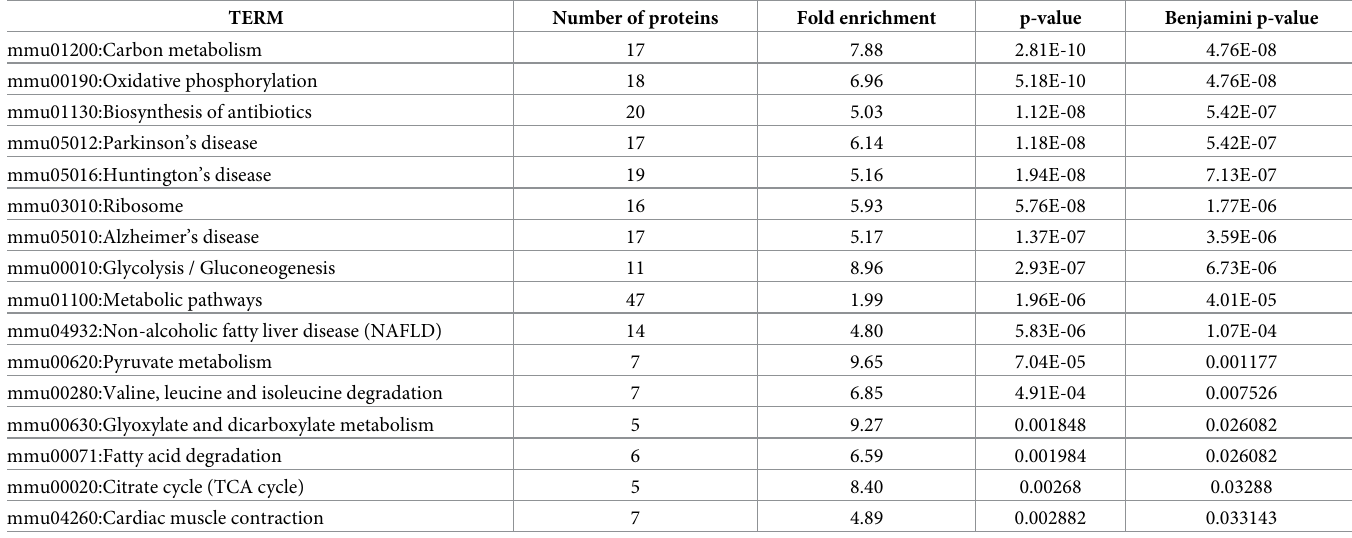
and 4C). We decided against using POH versus Sham to evaluate enzyme activities because POH often alters total protein levels (like for CPT1B) along with other posttranslational modifica- tions, which would affect results separately from O-GlcNAc status. Thus, we compared V-TAC versus TMG-TAC to better isolate and assess O-GlcNAc’s specific effects on protein functions during POH [10]. Total CPT1B levels were similar in V-TAC versus TMG-TAC (denoted as the input for the IP), however CPT1B was greater in TMG-TAC after IP indicating higher CPT1B O-GlcNAcylation for TMG-TAC (Fig 4D–4F)). We found CPT1 enzyme activ- ity was higher in TMG-TAC versus V-TAC suggesting O-GlcNAcylation increases CPT1 activity during POH (Fig 5).